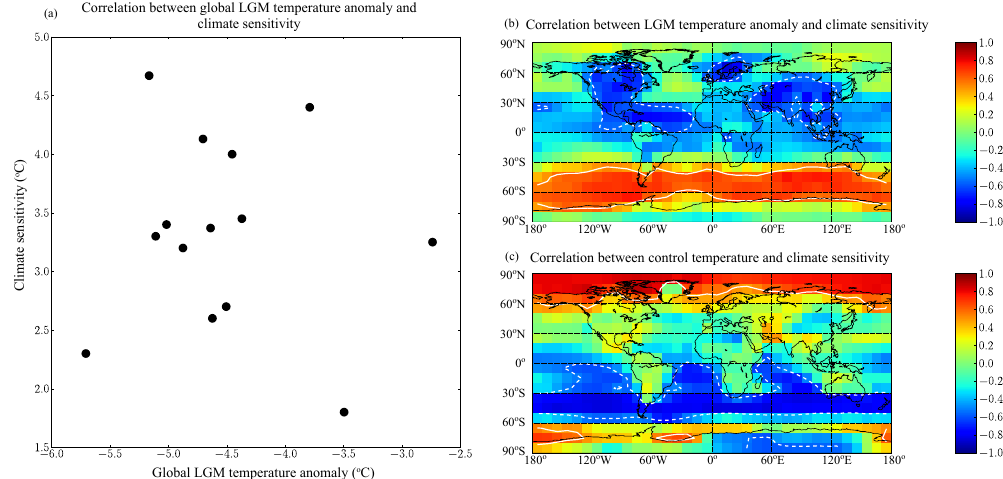
Fig. 4. (a) Global mean LGM temperature change versus overall climate sensitivity to 2xCO 2 . (b) correlation between local LGM air temperature anomaly and climate sensitivity across the model ensemble. (c) correlation across the model ensemble between control run temperatures and climate sensitivity.